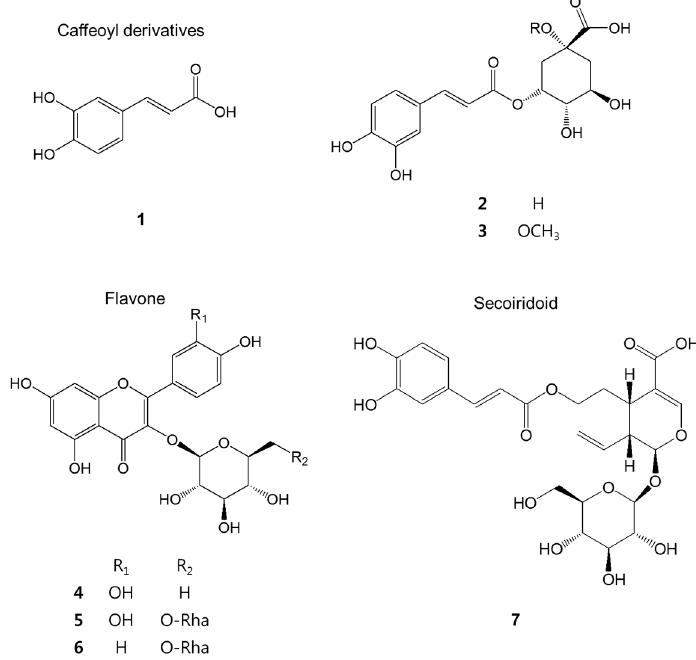
Figure 1. The chemical structure of the isolated compounds.